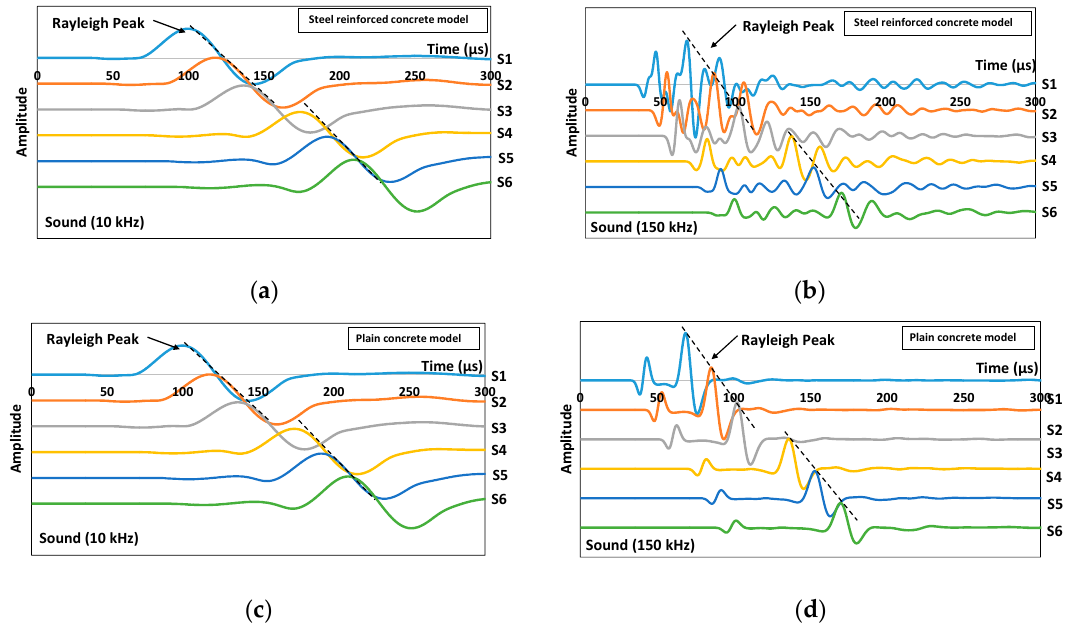
Figure 2. Simulated waveforms collected for steel reinforced concrete model using ( a ) 10 kHz and ( b ) 150 kHz excitations as well as the plain concrete model using ( c ) 10 kHz and ( d ) 150 kHz excitations.